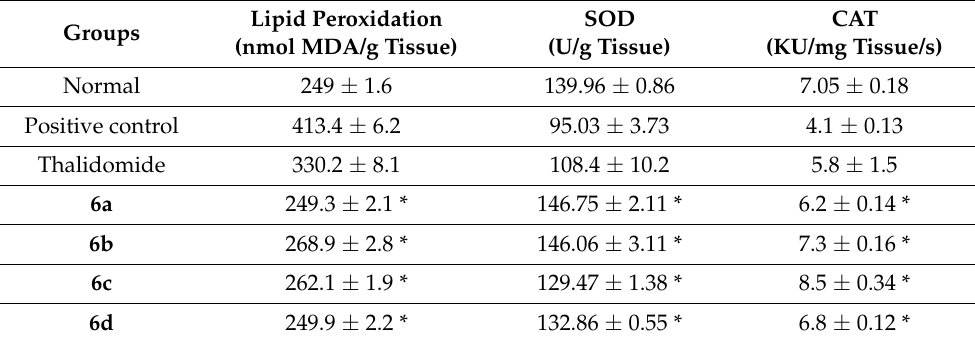
Table 5. Effect of tested indoloquinoline derivatives on lipid peroxidation and antioxidant enzymes in solid-tumor bearing mice.